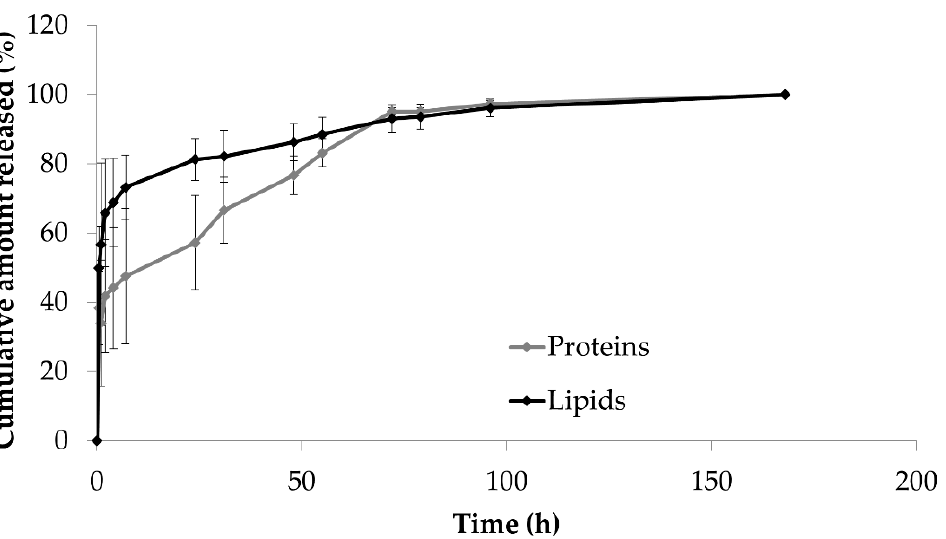
Figure 3. In vitro protein and lipid release profiles from SBlyo scaffolds immersed in pH 7.2 PBS at room temperature. Mean values ± standard deviation, n = 3.